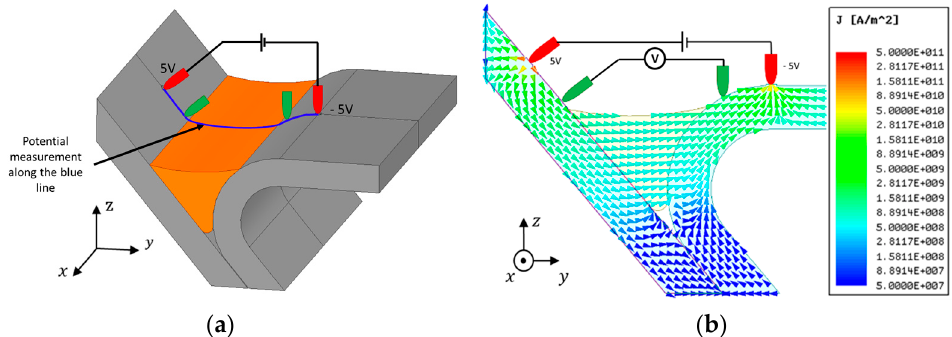
Figure 3. Four-point probe numerical simulation: ( a ) pins positioning towards the profile; ( b ) current flow through the weld.